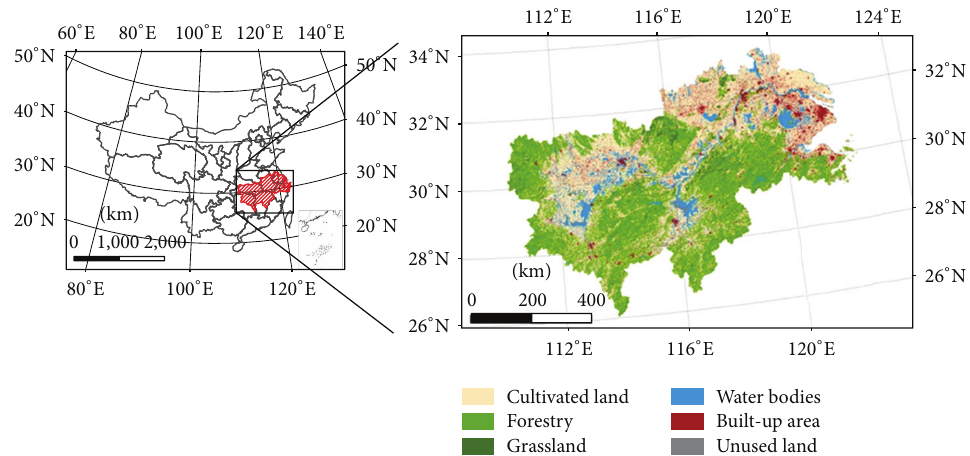
Figure 1: Location of the study area and the land cover, 2008.